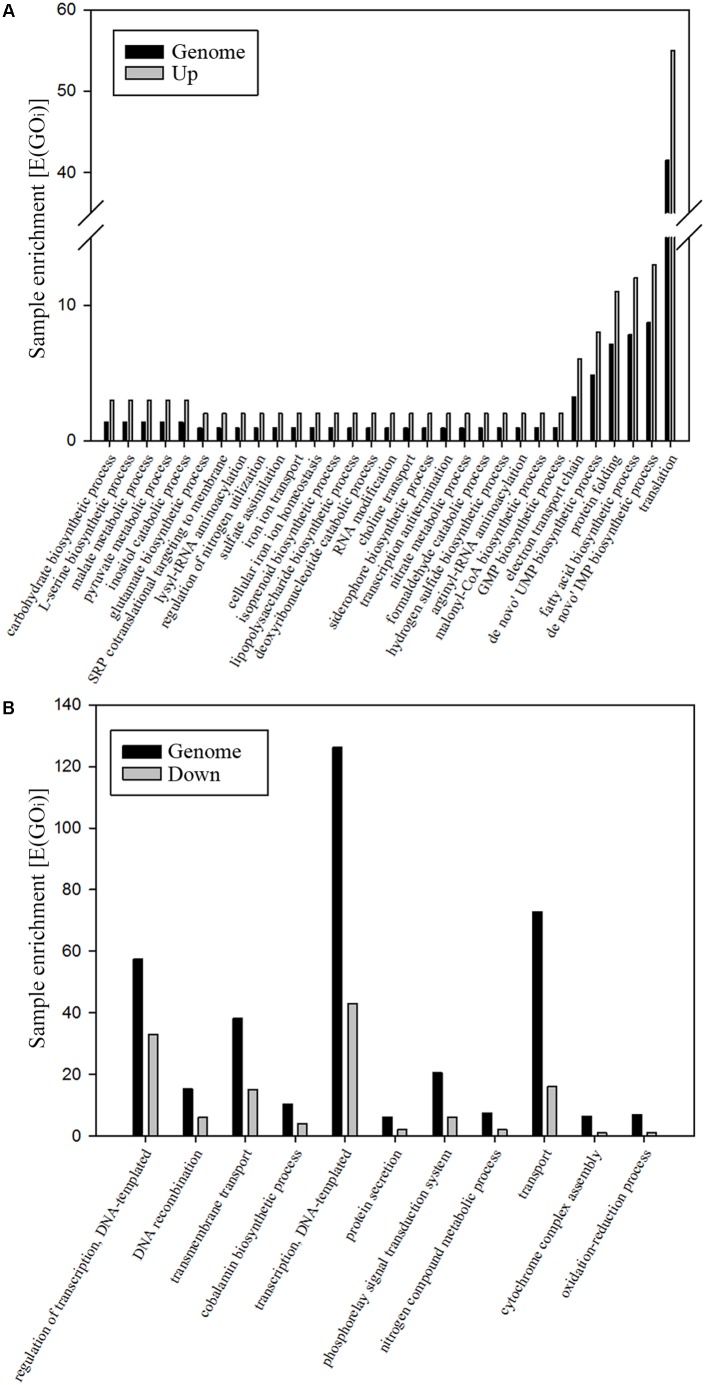
Analysis of the denitrification proteome of P. denitrificans PD1222. Significative changes in GO groups. Only those changes with a p-value < 0.05 are shown. The whole genome of P. denitrificans PD1222 was used as reference (black bars) and over-represented (A) and down-represented (B) GO groups are shown (gray bars). Hyper-geometric distribution [E(GOi)] of GO (ComparativeGO), biological function, third level of proteins identified under denitrifying conditions. The parameter E(GOi) is calculated by using the formula: [E(GOi)] = sample size/genome size × GOi.